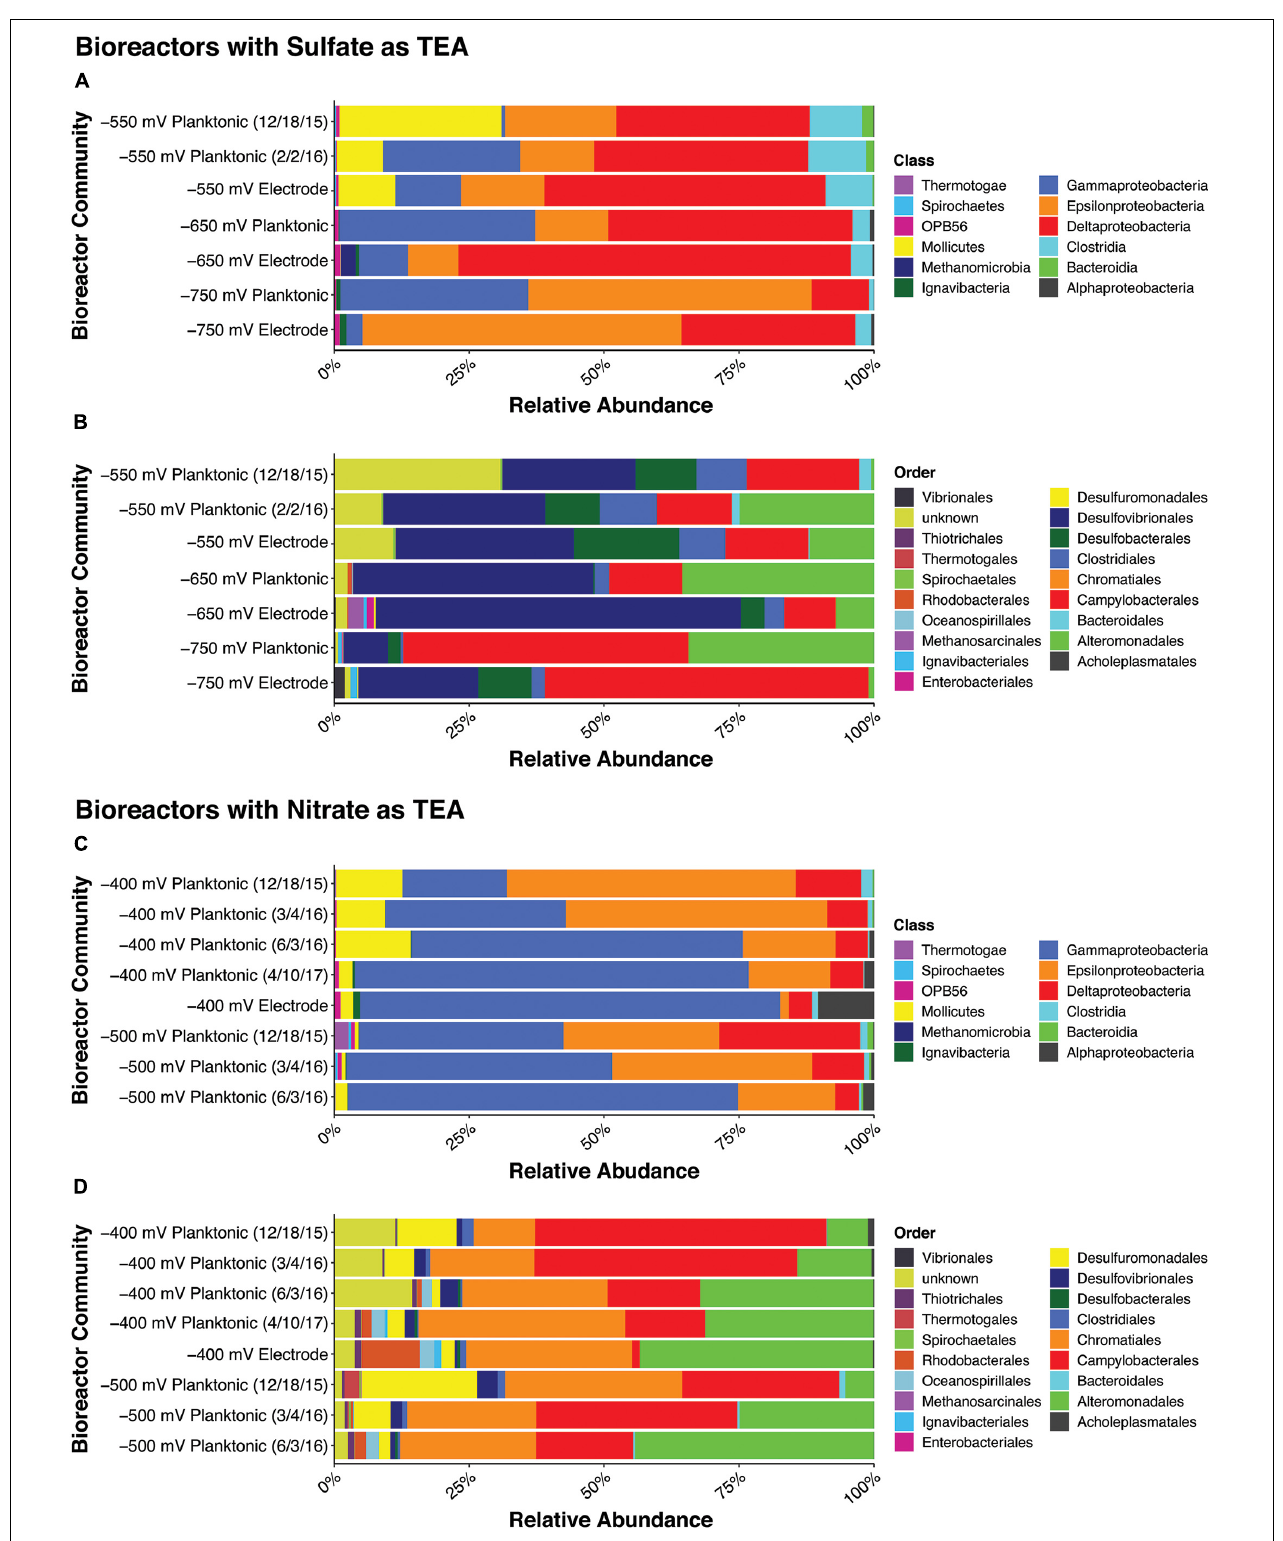
FIGURE 2 | Relative abundances for each bioreactor community samples at the class (top 100 OTUs) and order (top 50 OTUs) level. The –550, –650, and –750 mV (vs. Ag/AgCl) sulfate electrochemical bioreactor communities are shown in (A) at the class level and in (B) at the order level. The –400 and –500 mV (vs. Ag/AgCl) nitrate bioreactor communities are shown in (C) at the class level and (D) at the order level.